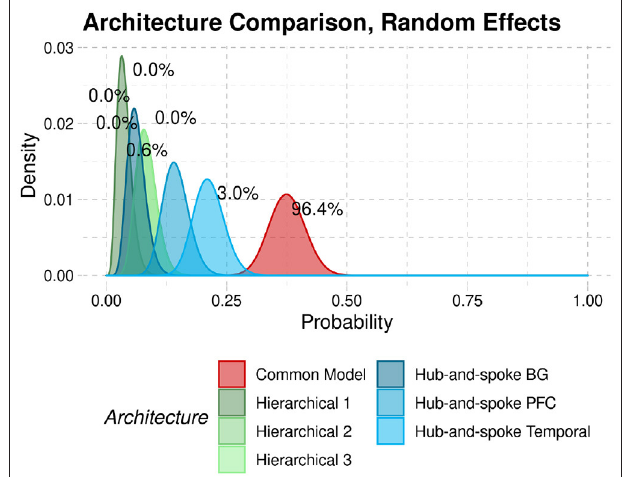
FIGURE 7 | The penalized log-likelihood (Free energy) of the CMC architecture compared to six alternate architectures across both sessions of rsfMRI data.